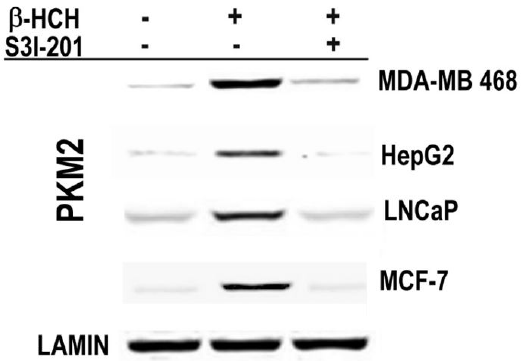
Figure 5. Immunoblot analysis of PKM2 in the nuclear extracts obtained from MDA ‐ MB 468, HepG2, LNCaP, and MCF ‐ 7 cell lines treated with β‐ HCH (10 μ M) for 4 h in the presence or absence of a specific STAT3 inhibitor (S3I ‐ 201). Lamin was used as specific nuclear marker and normalization protein.